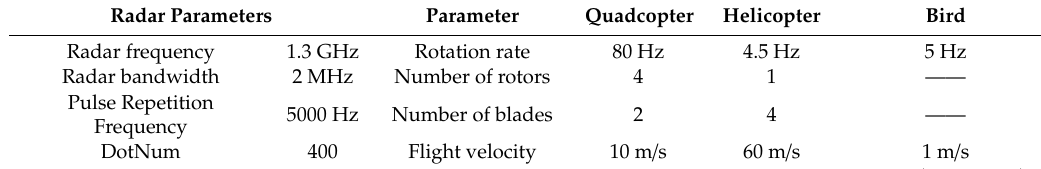
Table 1. Radar and target parameters.